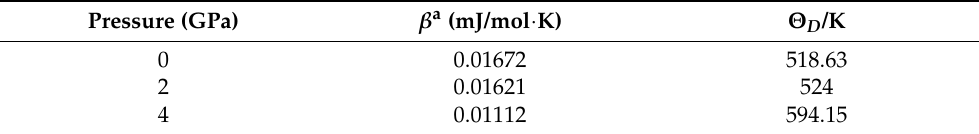
Table 3. The Debye temperature of hyper-peritectic Al-47wt.%Ni alloy solidified under different